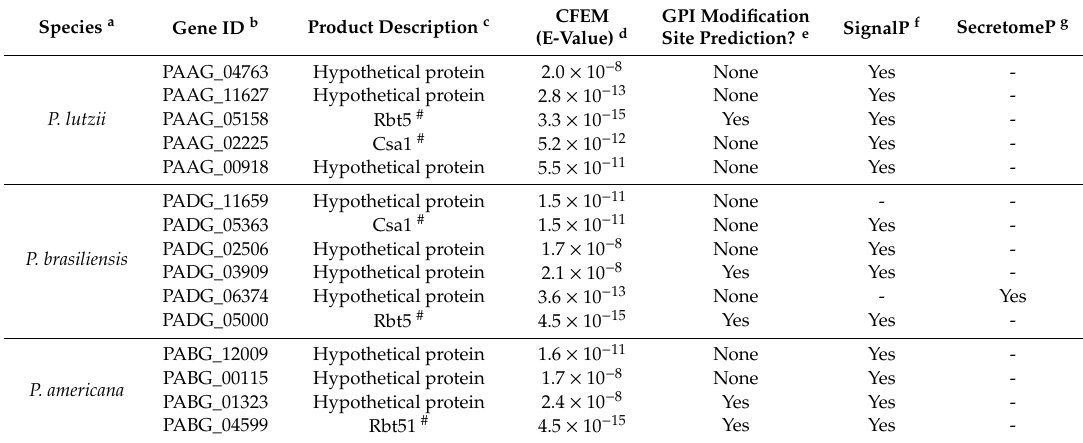
Table 1. The putative CFEM proteins in Paracoccidioides spp. Genomes